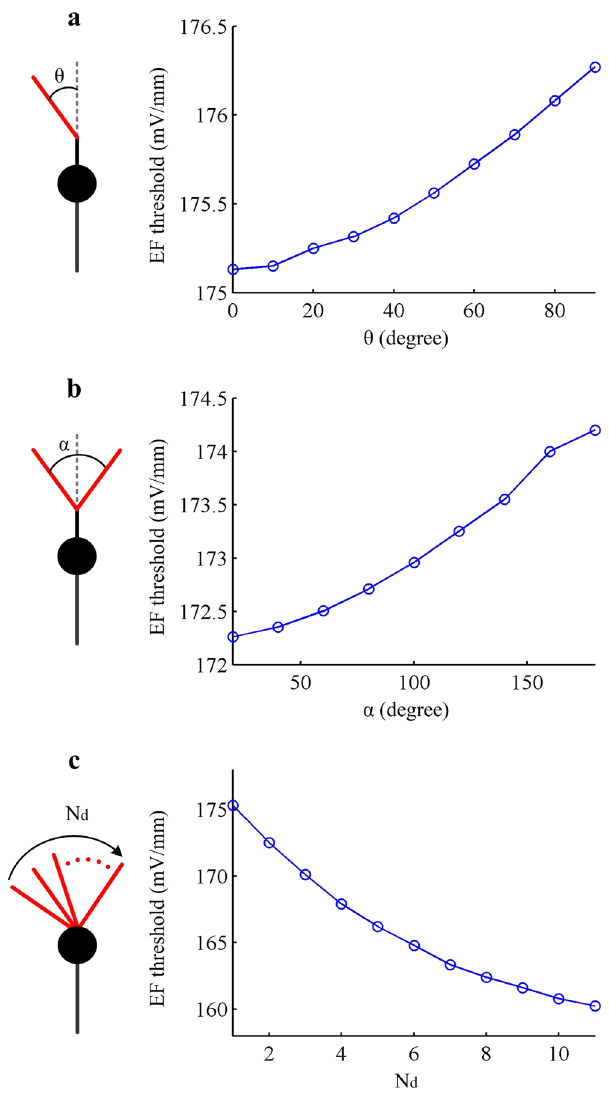
Figure 4. Basic morphologies of dendrites affect EF firing threshold in artificial model. EF threshold for evoking APs is respectively showed as a function of (a) bend angle β , (b) bifurcation angle α , and (c) branch number N d of the dendrite. The diameter and length of each dendrite are 2 μ m and 8 μ m. Other morphological and biophysical parameters of the artificial neuron are as indicated in